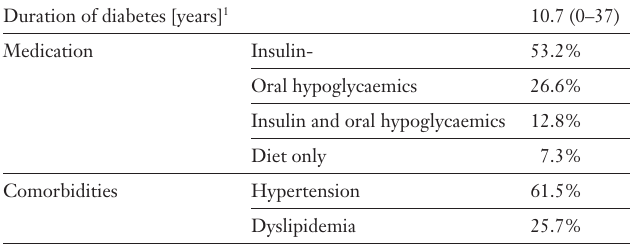
Characteristics of the diabetic